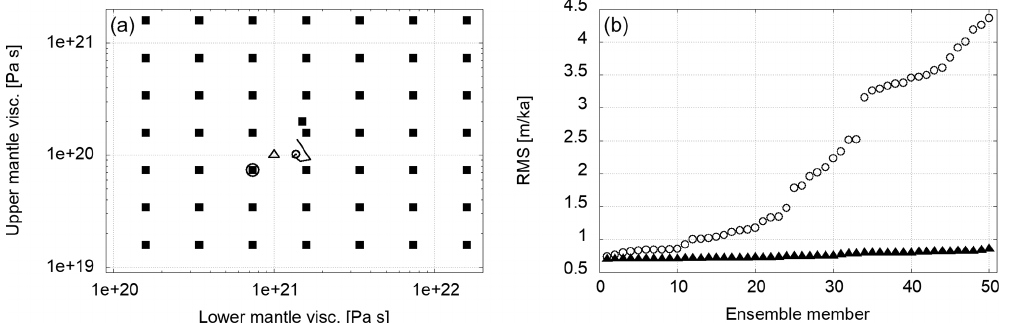
Figure 22. (a) Viscosities of the (initial) ensemble for the comparison between assimilation and classical approach (solid squares), final mean state of assimilation approach (small circle), and target values (triangle). The black line is the path of the mean state during the assimilation after each resampling step. The larger circle denotes the member of the classical approach ensemble with lowest RMS error. (b) RMS errors of RSL rates of change for the ensemble of the classical approach (circles) and PF approach